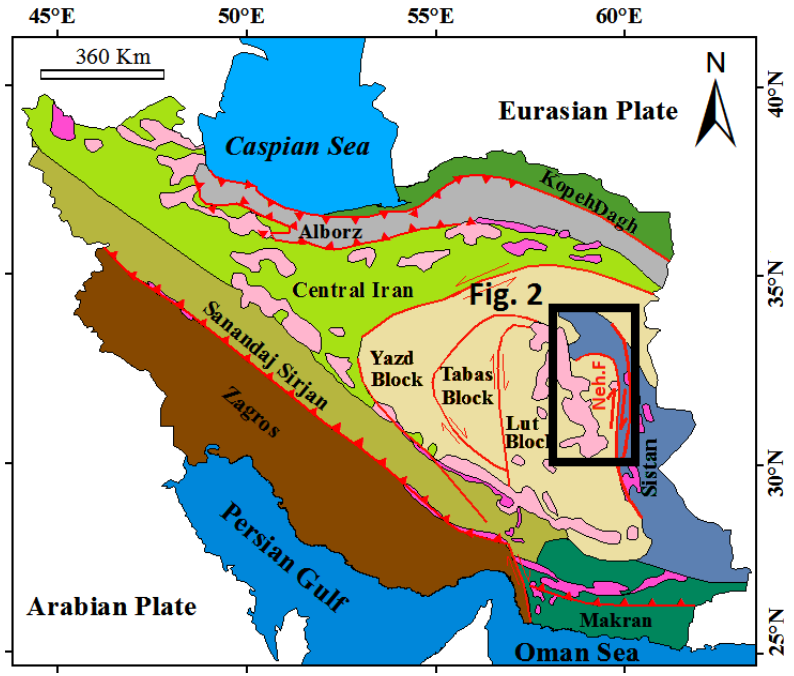
Figure 1. The structural zones of Iran. The black rectangle shows the area where the study took place (Neh. F = Nehbandan fault).